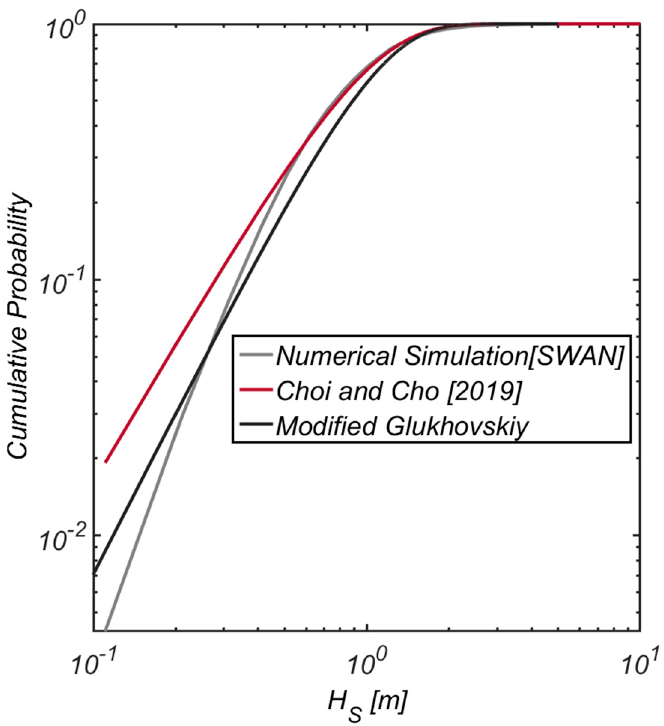
Figure 5. Comparison of wave height probability distribution functions with the modified Glukhovskiy and the one derived by Choi and Cho [1].